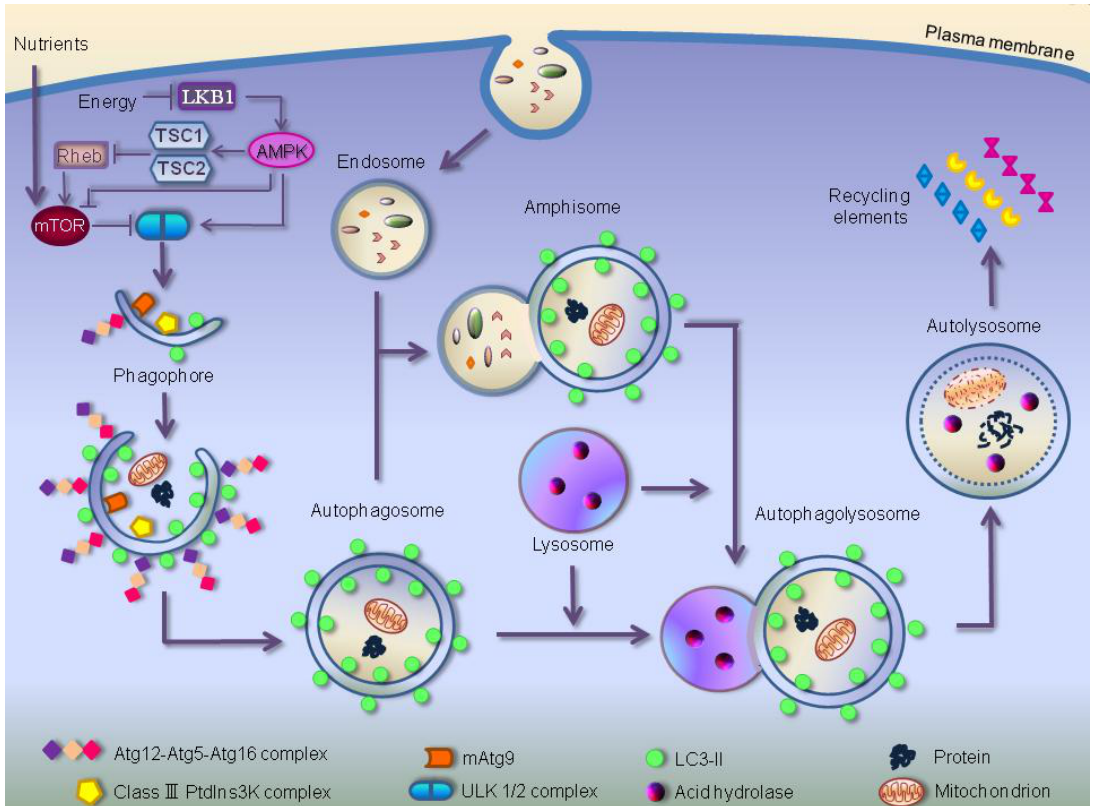
Figure 1. The process of autophagy in mammalian cells. Autophagy is initiated by the formation of the phagophore, mediated by the class-III phosphatidylinositol 3-kinase (PtdIns3K) complex that includes hVps34, the yeast Vps15 homologue, p150, Beclin1, and human Atg14/Barkor, and followed by a series of steps. These include the elongation and expansion of the phagophore, closure of a double-membrane autophagosome engulfing material targeted for degradation, such as damaged organelles and long-lived misfolded/aggregated proteins, autophagosome maturation through fusion with an endosome (the product of fusion is known as an amphisome) and/or lysosome (the product of fusion is known as an autophagolysosome), degradation of the vesicle content by acid hydrolases inside the autolysosome and recycling of the degradation products (amino acids, lipids and sugars) for ATP production. Autophagy induction is mediated by the kinase activity of ULK1/2 complex. Energy depletion causes the phosphorylation and activation of AMP-activated protein kinase (AMPK) by the serine/threonine kinase LKB1. AMPK directly phosphorylates the tuberous sclerosis complex 1/2 (TSC1-TSC2), leading to the inactivation of the small GTPase Rheb, which in unstressed cells binds and activates the master regulator of autophagy, mTOR (mammalian target of rapamycin kinase), inducing autophagy. AMPK also associates with ULK1, playing an important role in autophagy induction. The core molecular machinery also requires the membrane carrier mAtg9, delivering membrane lipids to the forming autophagosome, and two conjugation systems for the elongation and extension of the phagophore membrane: LC3-II, which is formed as a result of the Atg4-mediated cleavage of cytosolic LC3, and the Atg12 (cid:177) Atg5 (cid:177) Atg16L complex, mediating LC3-II recruitment to the